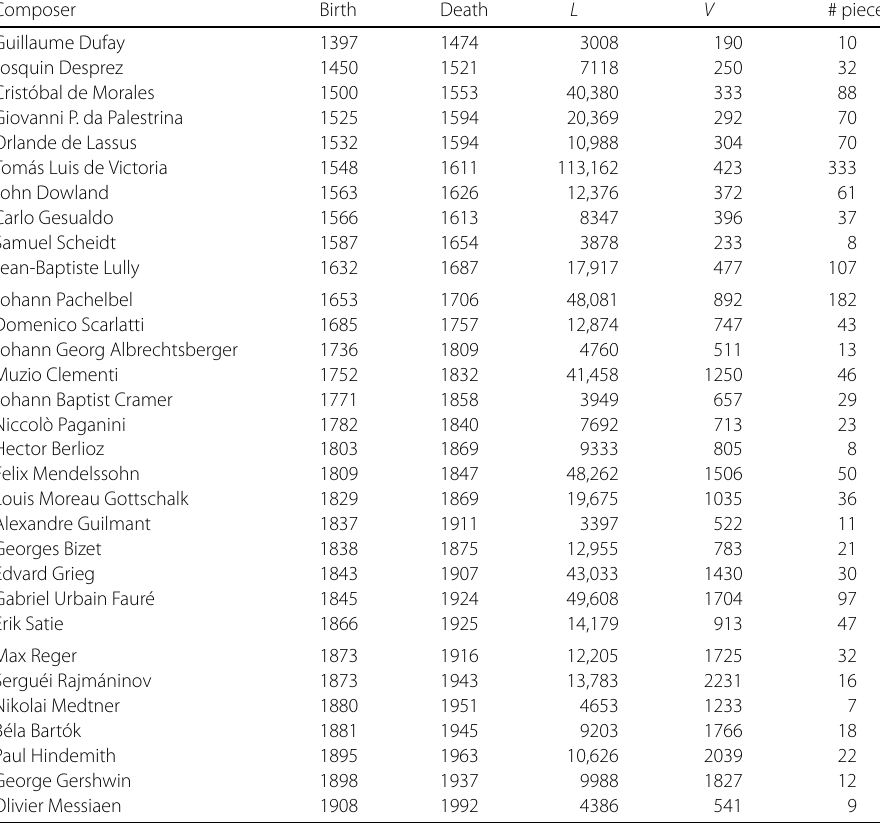
Table 5 As Table 2, but for the composers that appear in Table 4 (and do not appear in the former), in chronological order. The horizontal line separates composers in the top-5, middle-6, and bottom-5 categories for relative richness and entropy (not for (cid:6) F (cid:7) ) Composer Birth Death L V #